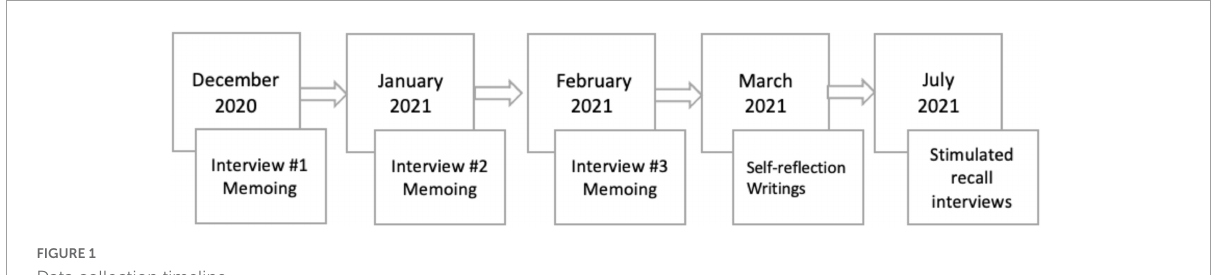
FIGURE1 Data collection timeline.